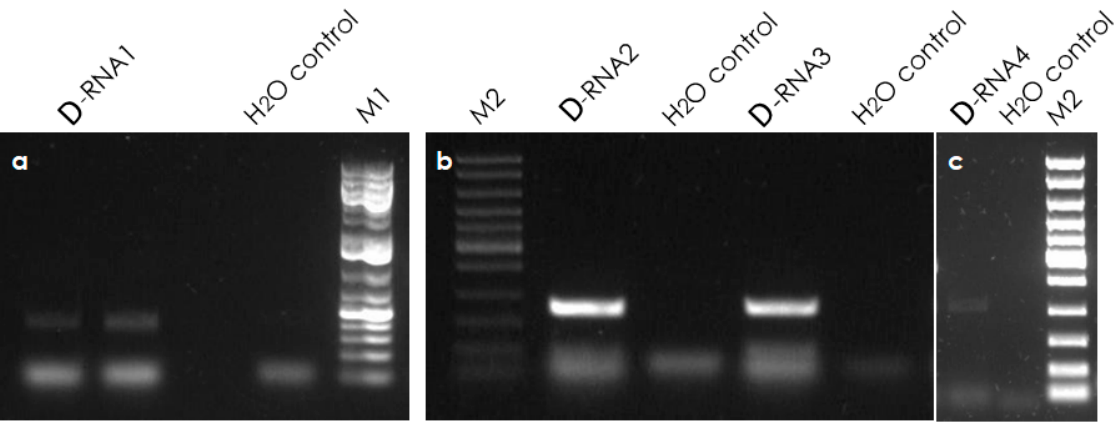
Figure 6. Gel red-stained 2% agarose gel showing RT-PCR products from: ( a ) D-RNA1 expected amplicon size 380 bp; ( b ) D-RNA2 and D-RNA3, expected amplicon size 380 bp and 400 bp, respectively; and ( c ) D-RNA4, expected amplicon size 500 bp. M1: GeneRuler 1 kb plus ladder (Thermo Scientific, SM1343). M2: fast DNA ladder 10 kb (NEB N3238S).